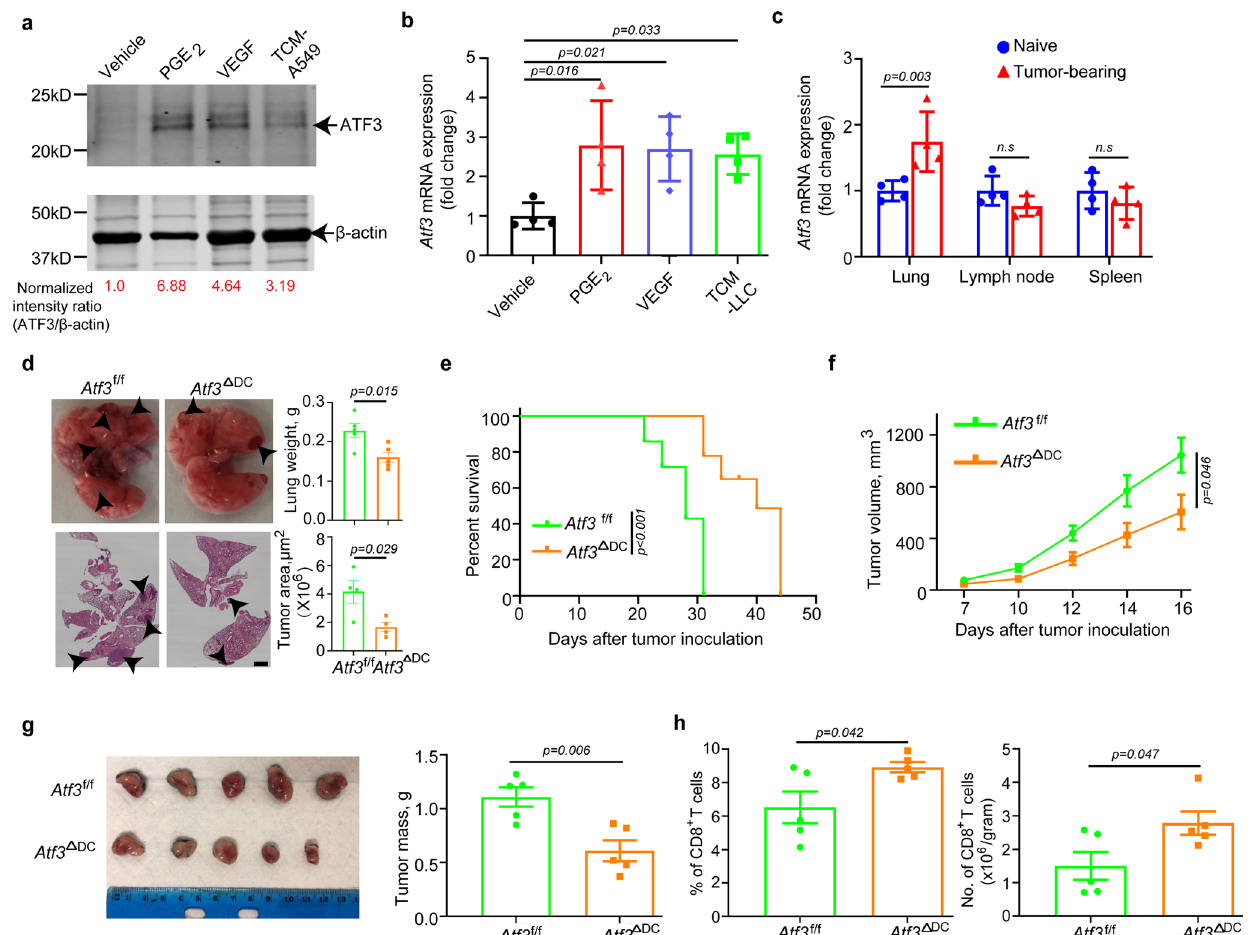
Fig.1|Tumormicroenvironmentfactors-inducedATF3inDCspromotestumor growth. a Immunoblot analysis of ATF3 levels in human monocytes treated with vehicle, Prostaglandin E 2 (PGE 2, 10ng/mL), vascular endothelial growth factor (VEGF,20ng/mL), ortumorcell-conditioned media(TCM — from A549cells,75%,v/ v)for1.5h.Levelsof β -actin(asaloadingcontrol)arealsoshown. b qPCRanalysisof Atf3 mRNAinmousesplenicCD11c + myeloidcellstreatedwithvehicle,PGE 2